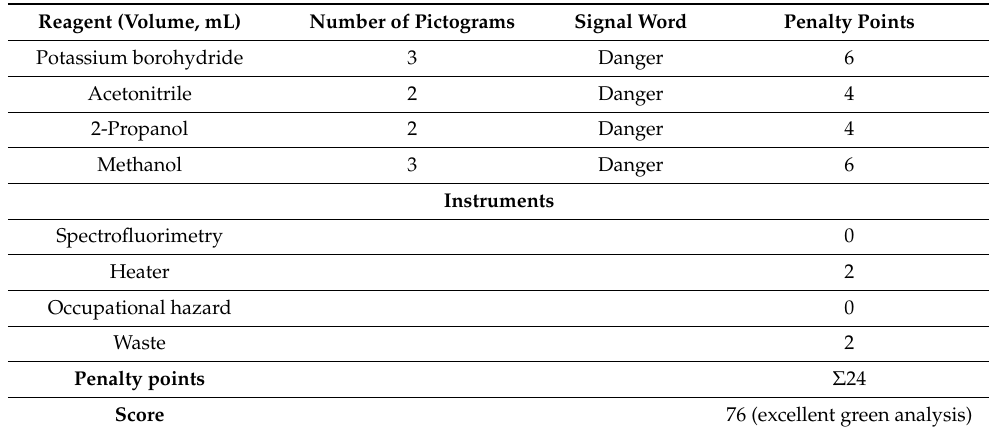
Table 7. Penalty points for the proposed method and calculation of its analytical eco-scale score. Reagent (Volume, mL)